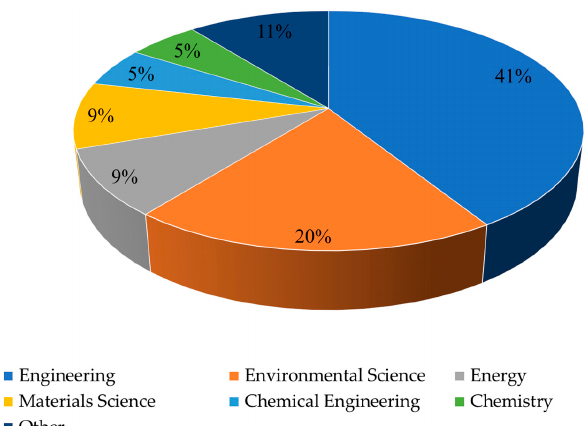
Figure 2. The subjects of the papers published in the years 1965–2021 for the key words “fuel oil combustion modifier”, authors’ report based on https://www.elsevier.com/pl-pl/solutions/scopus (accessed on 27 October 2022).